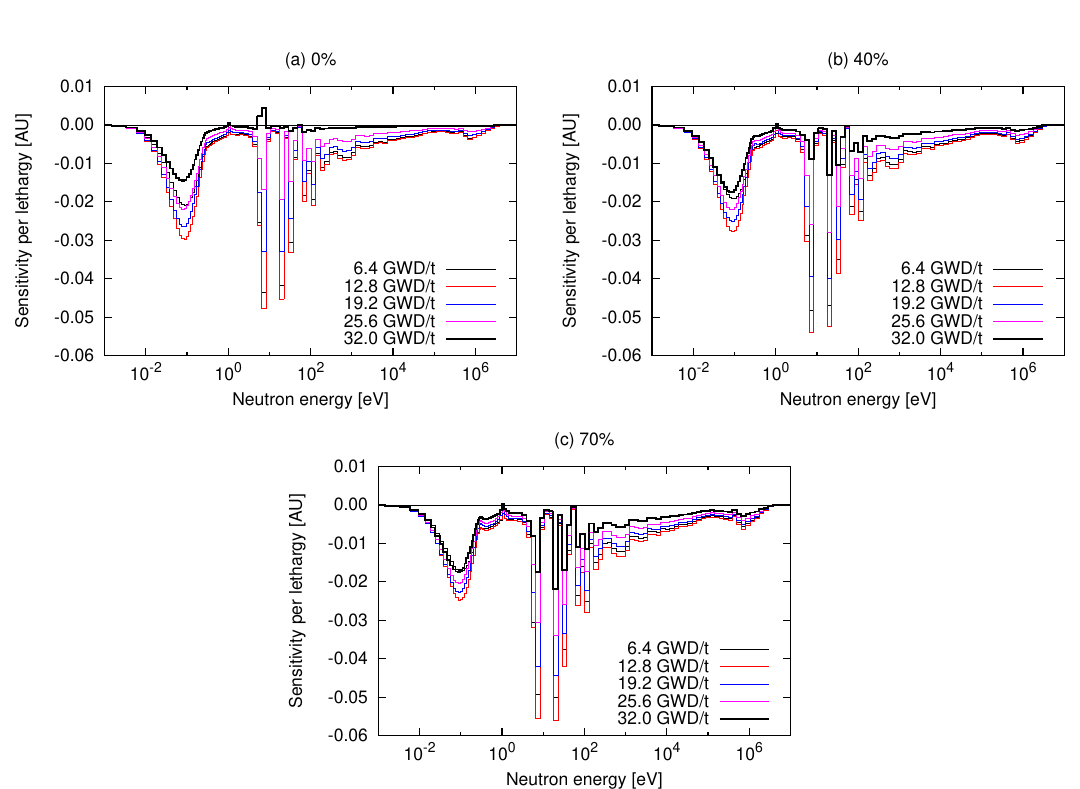
-0.06-0.05-0.04-0.03-0.02-0.010.000.01 Figure 4: Sensitivity of k